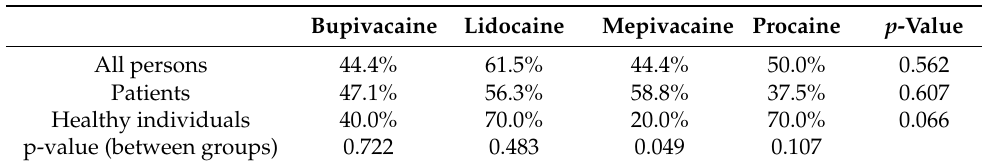
Table 3. Number of responders with a ≥ 85% reduction of TNF- α -production of the WBC after